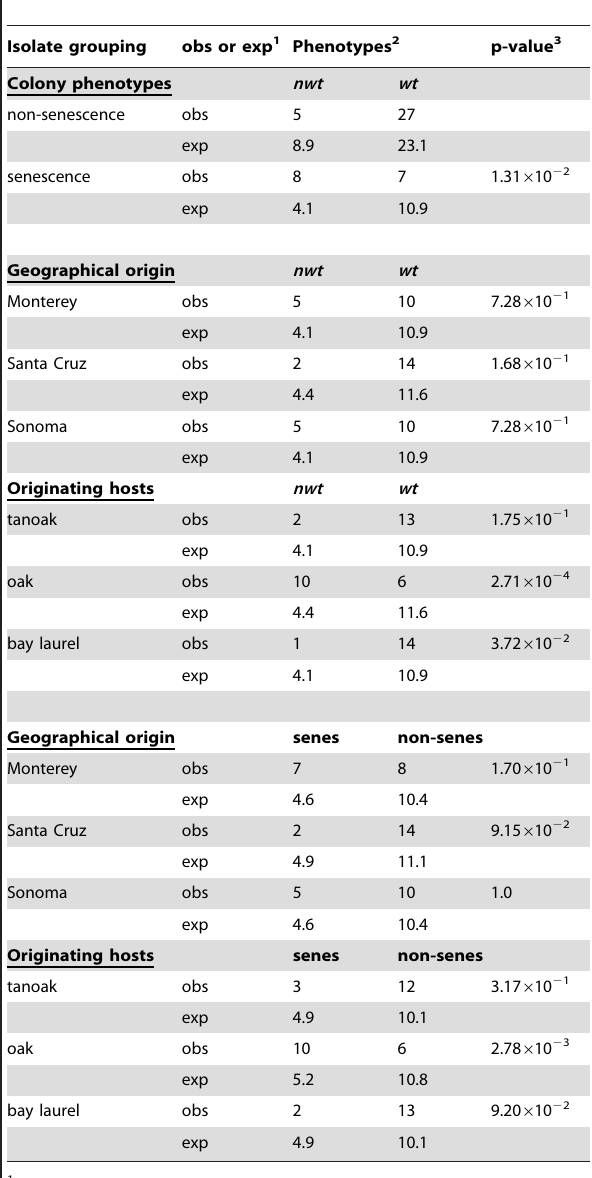
Table 2. Association of colony phenotypes and P. ramorum